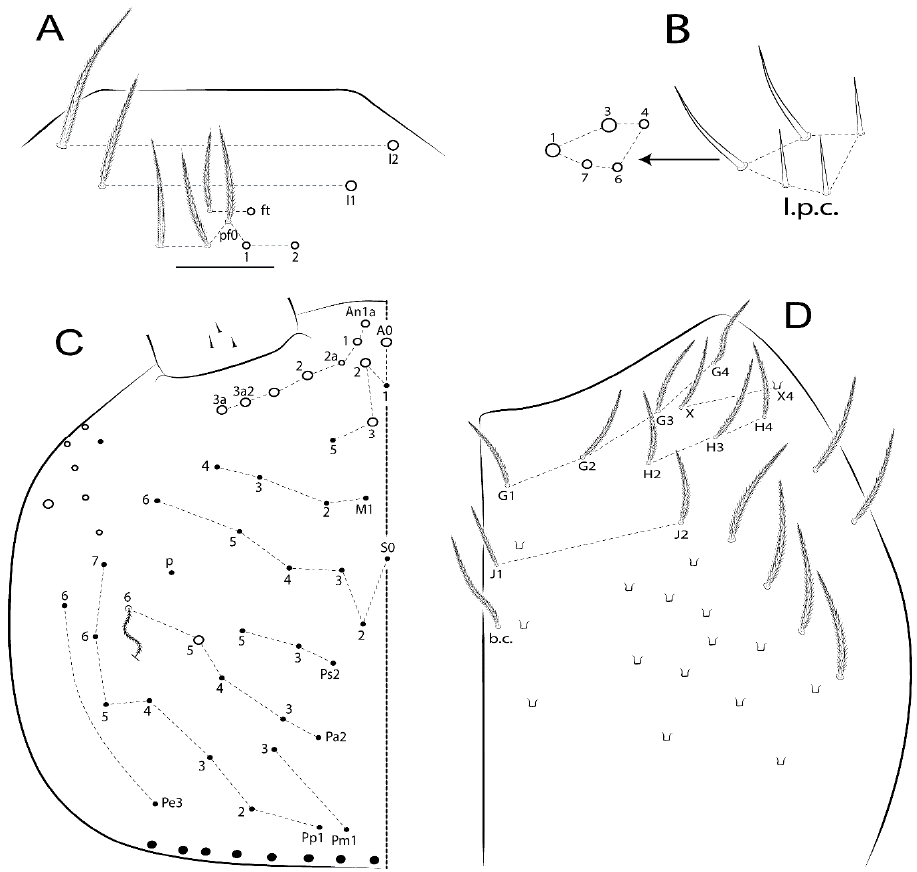
Figure 6. Pseudosinella guanhaensis : head. ( A ) Chaetotaxy of the clypeus; ( B ) labial proximal chaetae, arrow indicates proximal chaetae nomenclature; ( C ) head dorsal chaetotaxy (left side); and ( D ) postlabial chaetotaxy (right side).